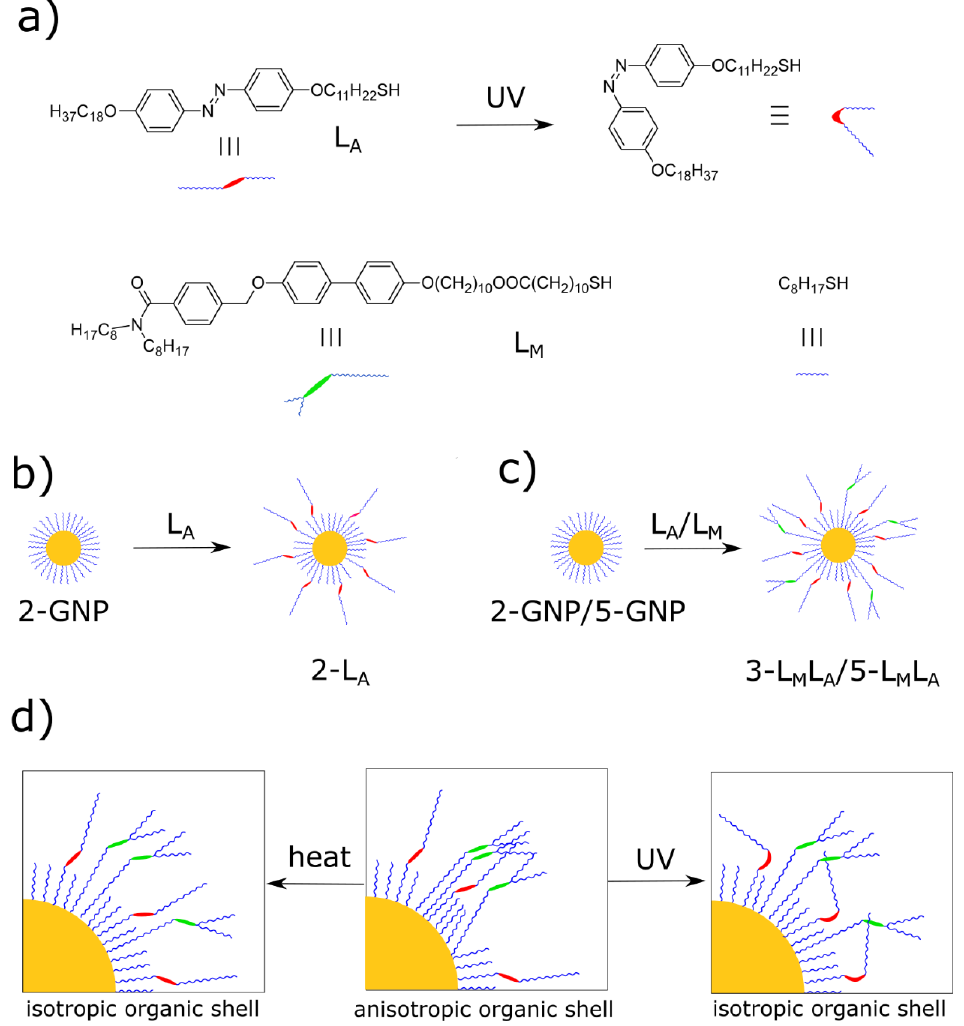
Figure 1. Preparation of photo- and thermo-responsive gold nanoparticle solids: ( a ) structure of a photoswitchable ligand L A and a mesogenic ligand L M ; ( b ) scheme of introduction of a photoswitchable ligand onto octanethiol-coated 2 nm gold nanoparticles; ( c ) introduction of photoswitchable and mesogenic ligands onto octanethiol-coated 2 nm and 5 nm gold nanoparticles; ( d ) a schematic representation of heat- and UV-induced reorganization of ligands on the surface of gold nanoparticles—the phenomena responsible for reversible reconfiguration of nanoparticle solids.